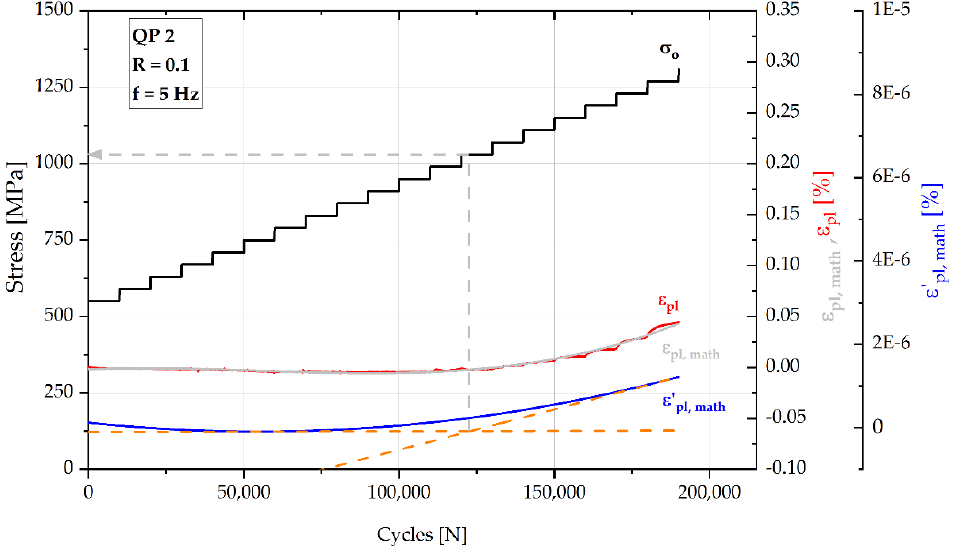
Figure 9. Load Increase Test for the QP2 condition.